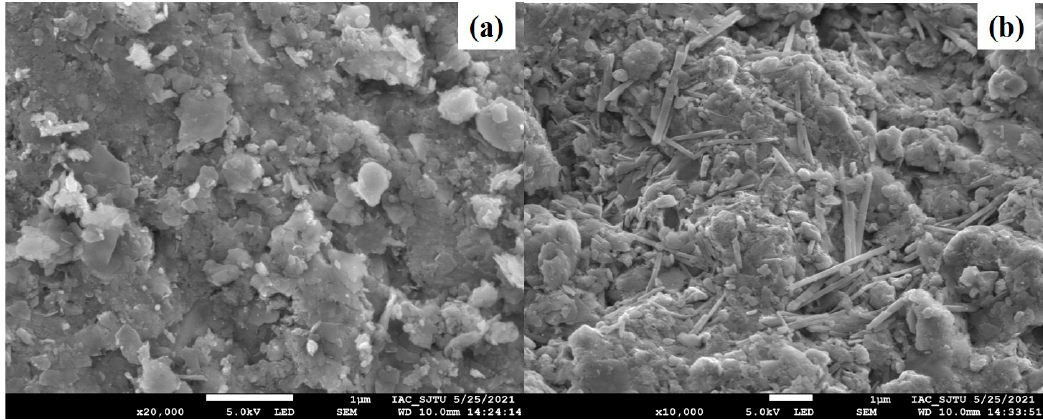
Figure 3. Surface morphology of BFS1 samples detected with SEM: ( a ) before P adsorption; ( b ) after P adsorption.